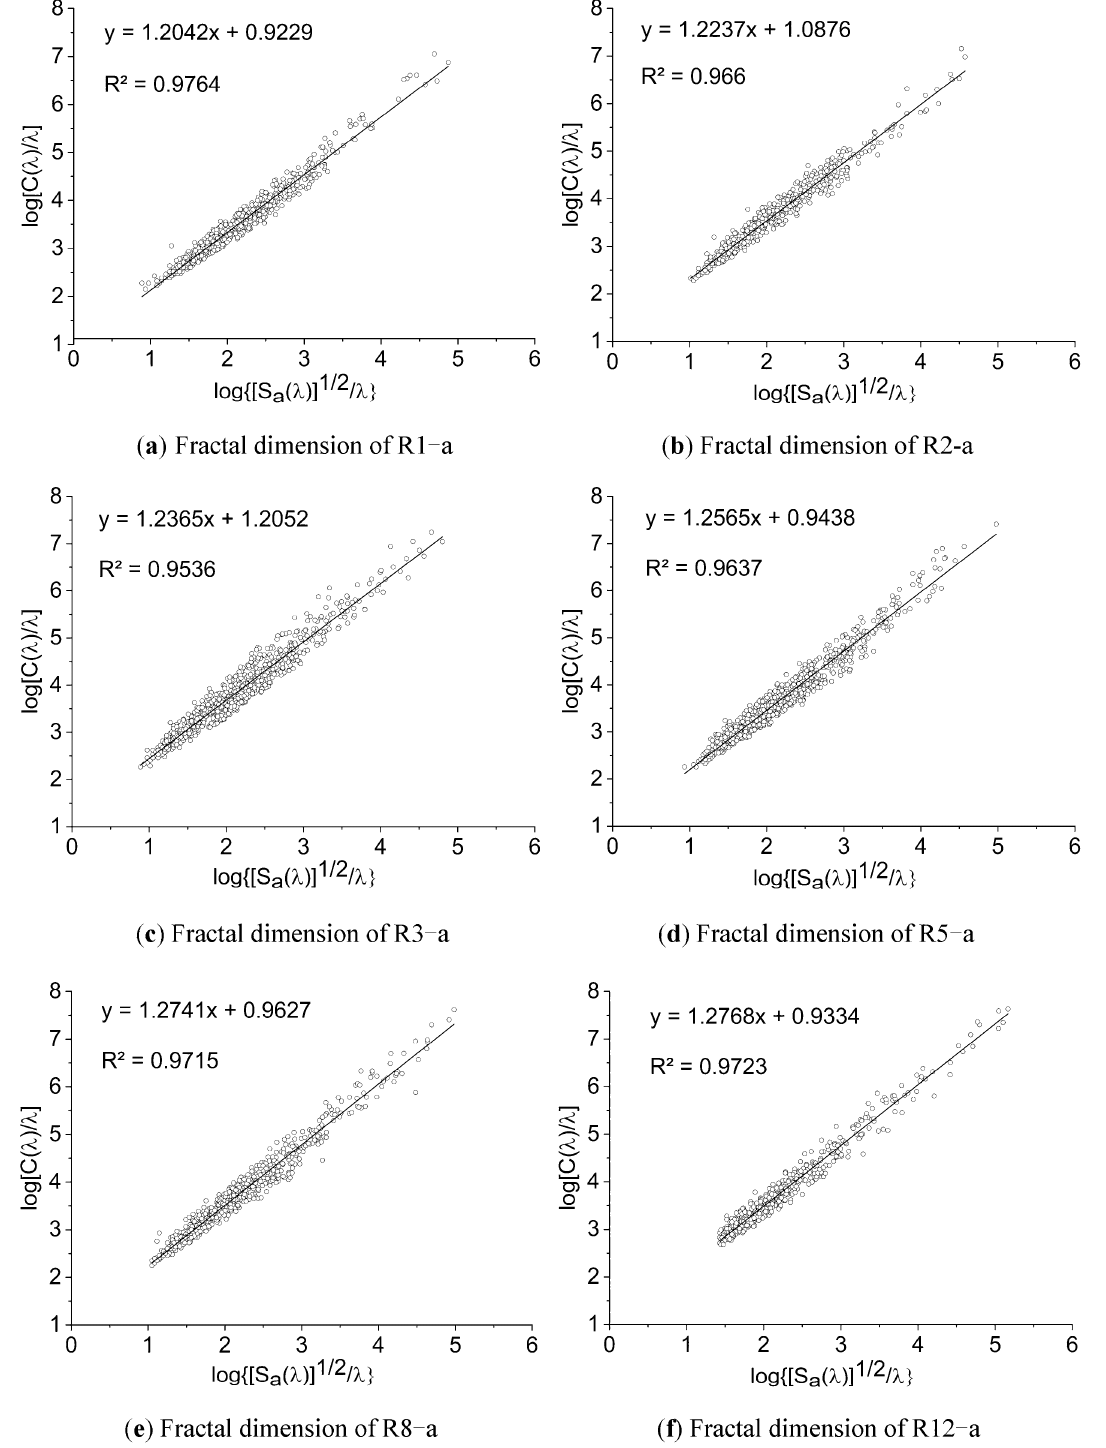
Figure 8. Fractal dimension fitting graphs of the pores in different water–rock interaction